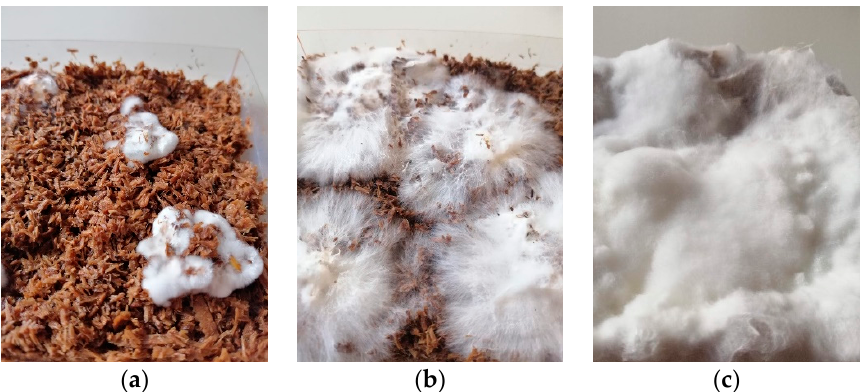
Figure 3. Close-up of the growth process of oyster mushroom mycelium on beech sawdust: ( a ) after three days; ( b ) after five days; ( c ) after 19 days.